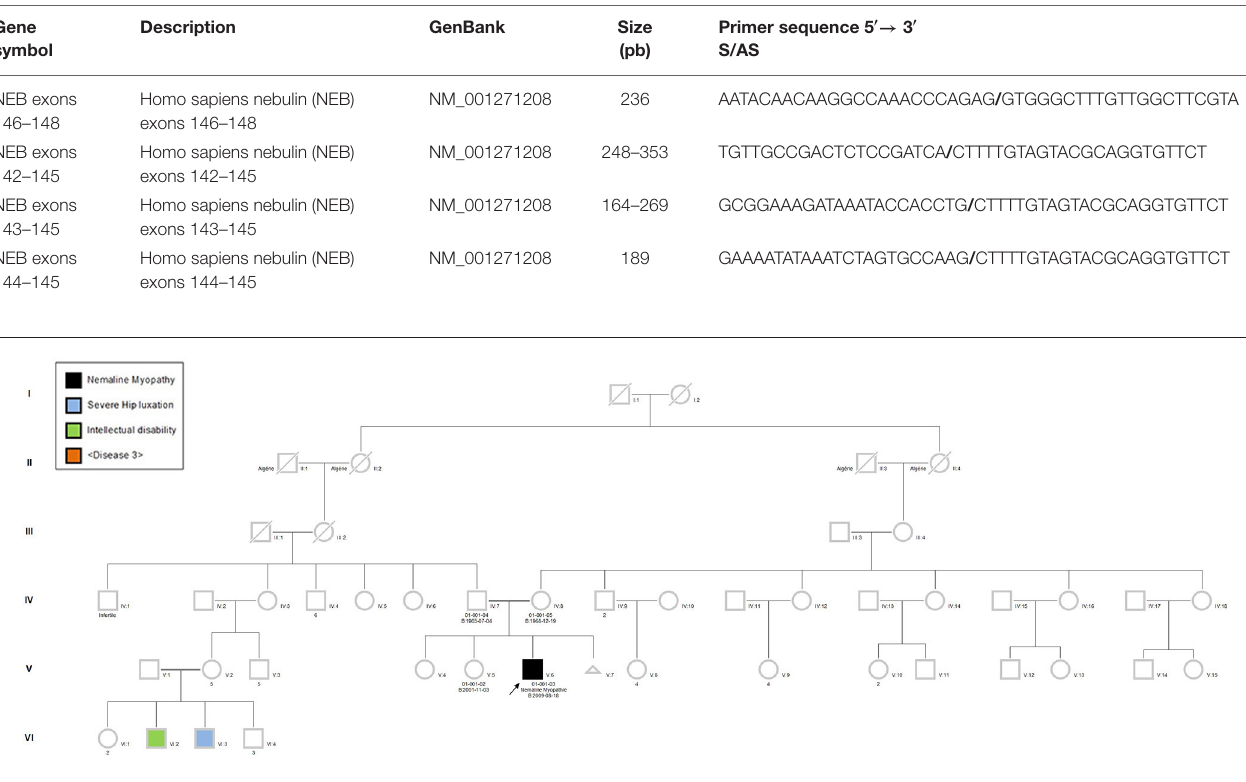
Qantitative Real-Time